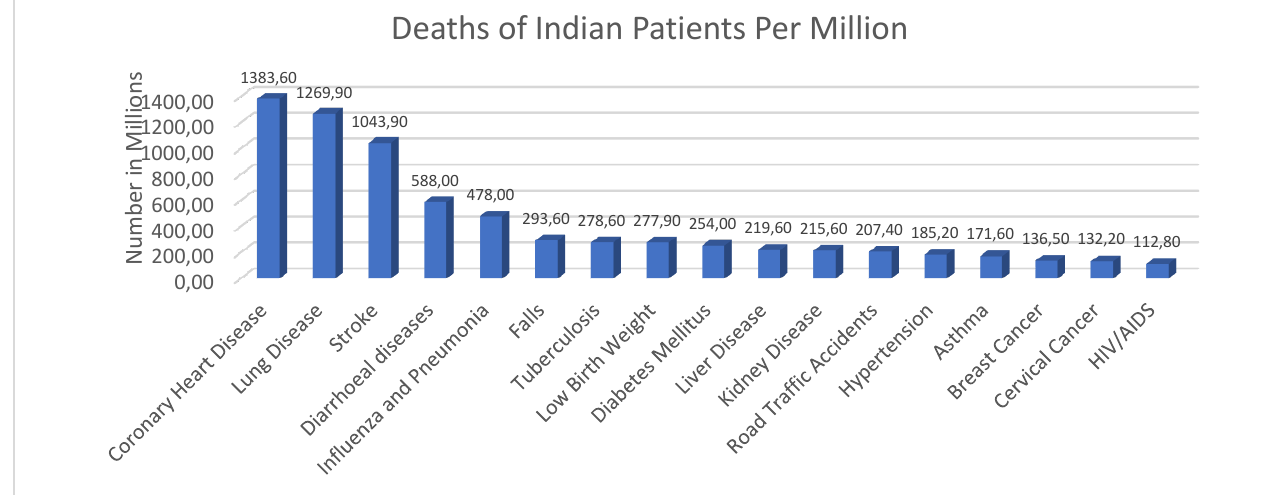
Figure 1 : Different Diseases and the Death Rate